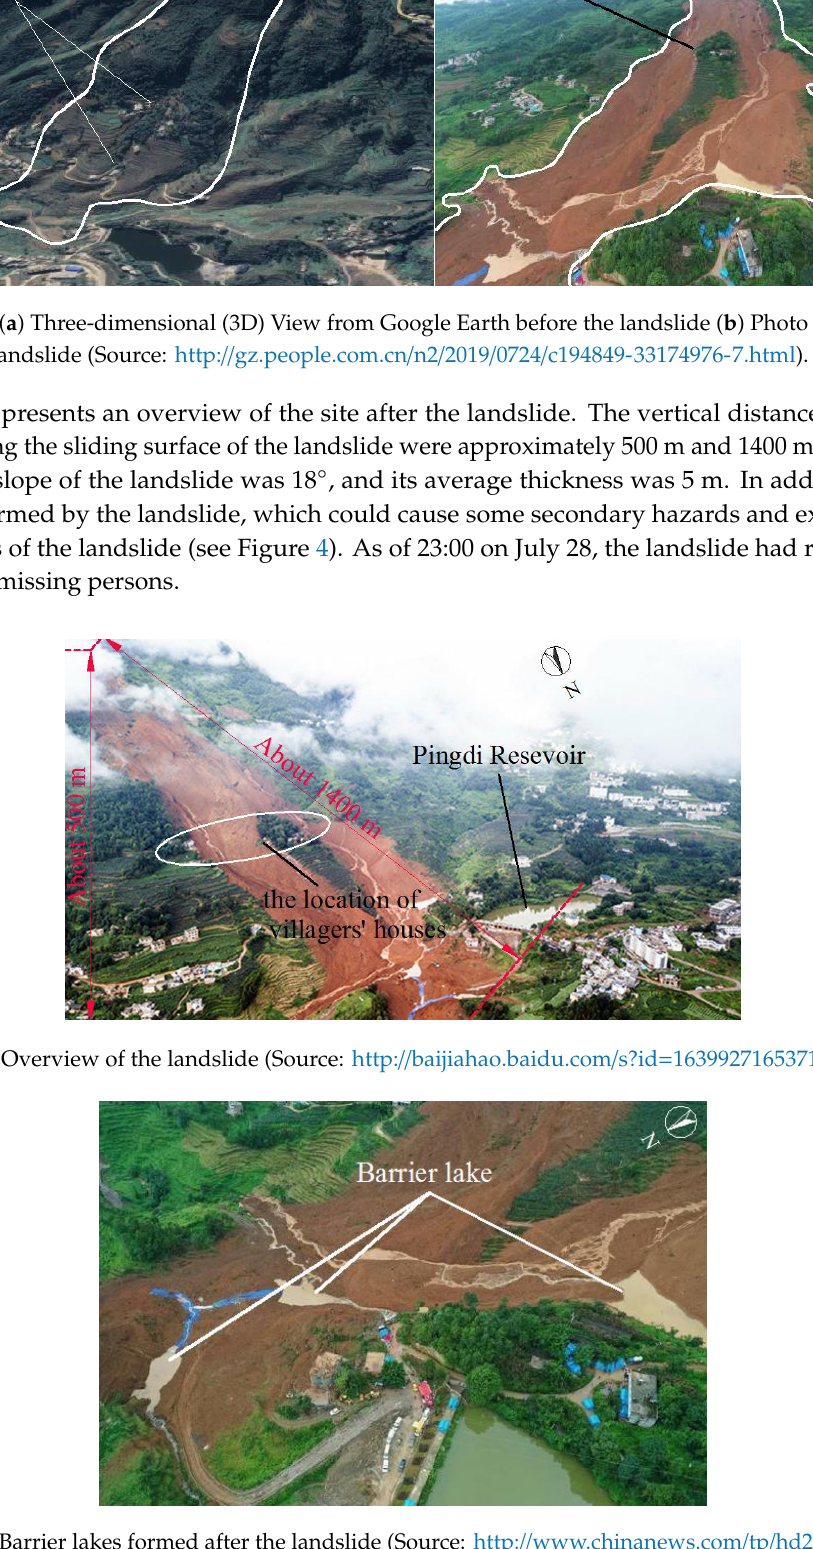
Figure 4. Barrier lakes formed after the landslide (Source: http://www.chinanews.com/tp/hd2011/2019/07-24/893609.shtml).